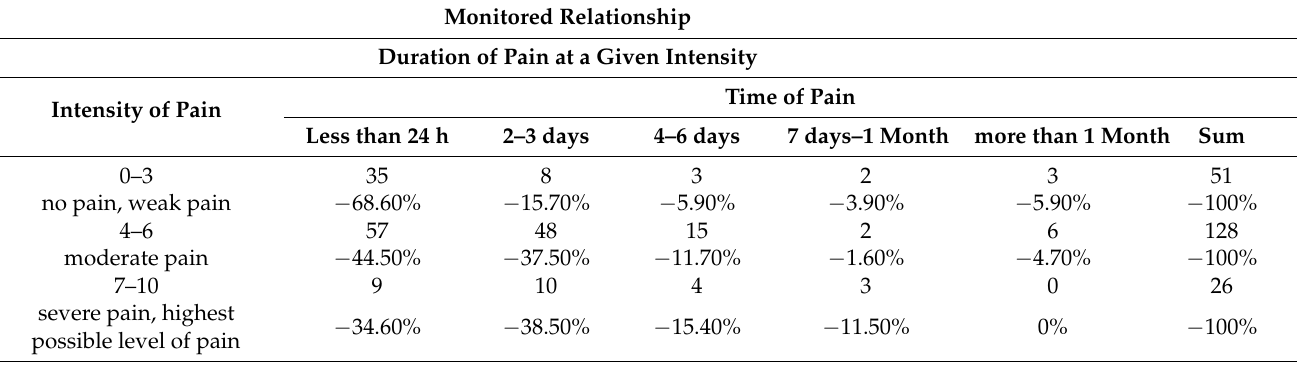
Table 3. Evaluation of the relationship between the current pain state and selected variables. Monitored